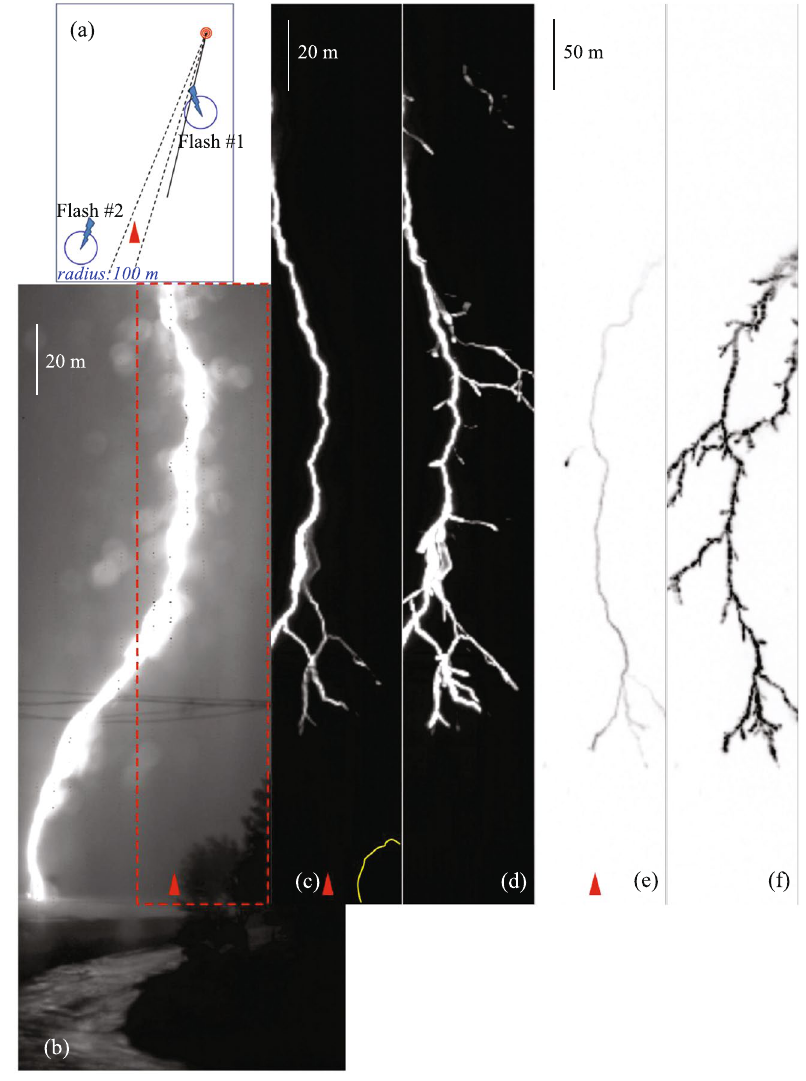
field angles. The black dashed lines indicate the field angle of the V711